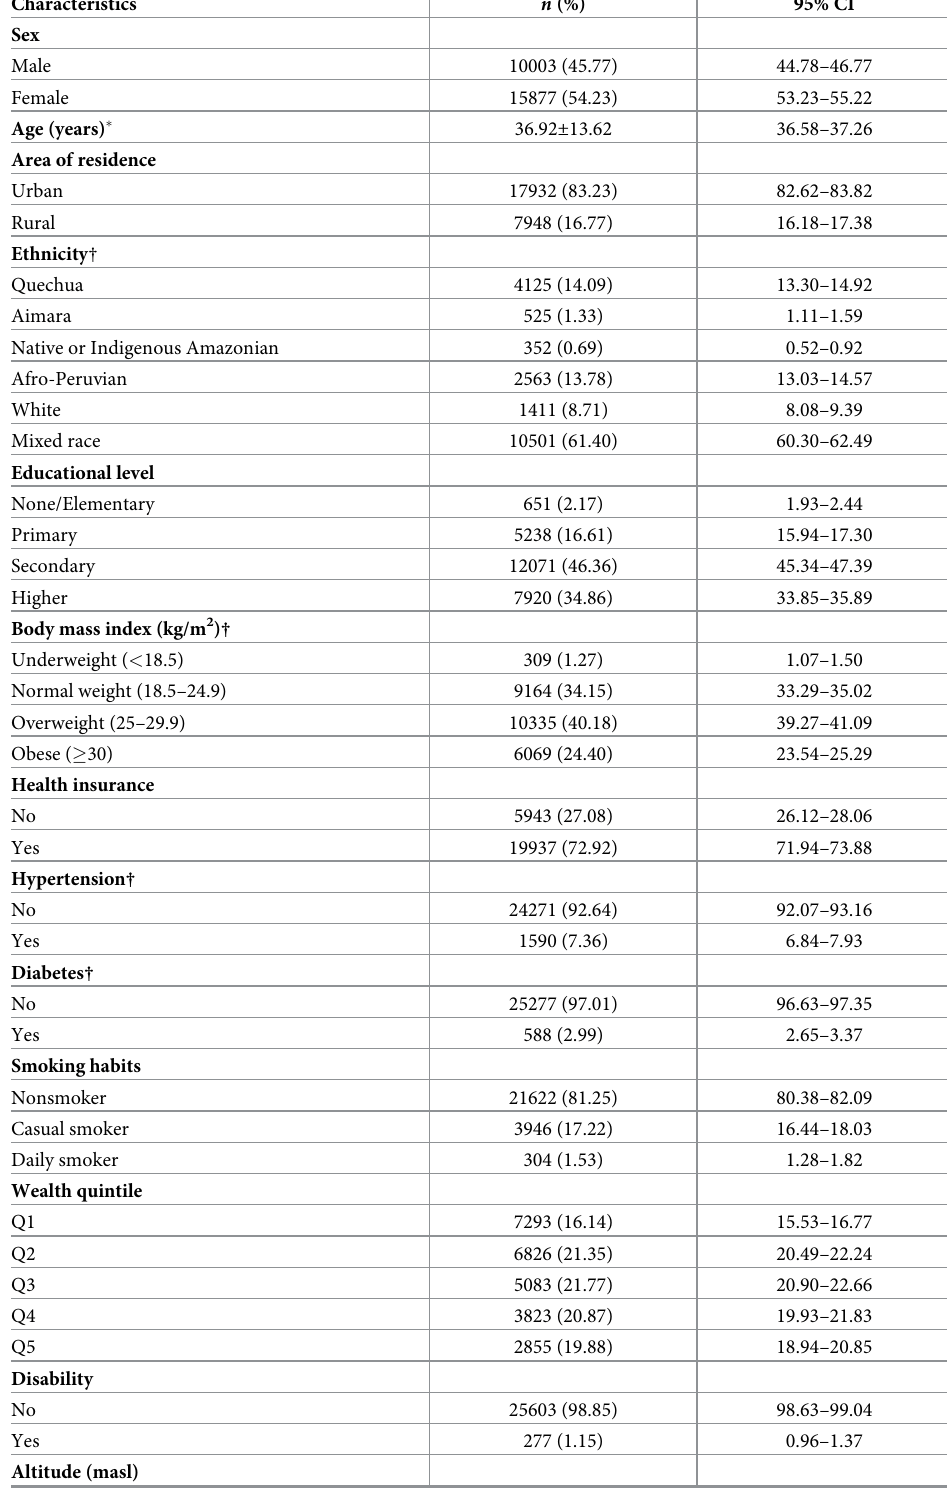
Table 1. Characteristics of the participants ( n = 25